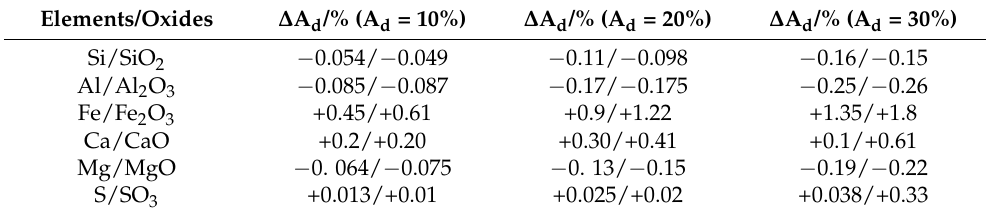
Table 2. Measured ash contents of coal when the content of high-Z elements increases by 1%.